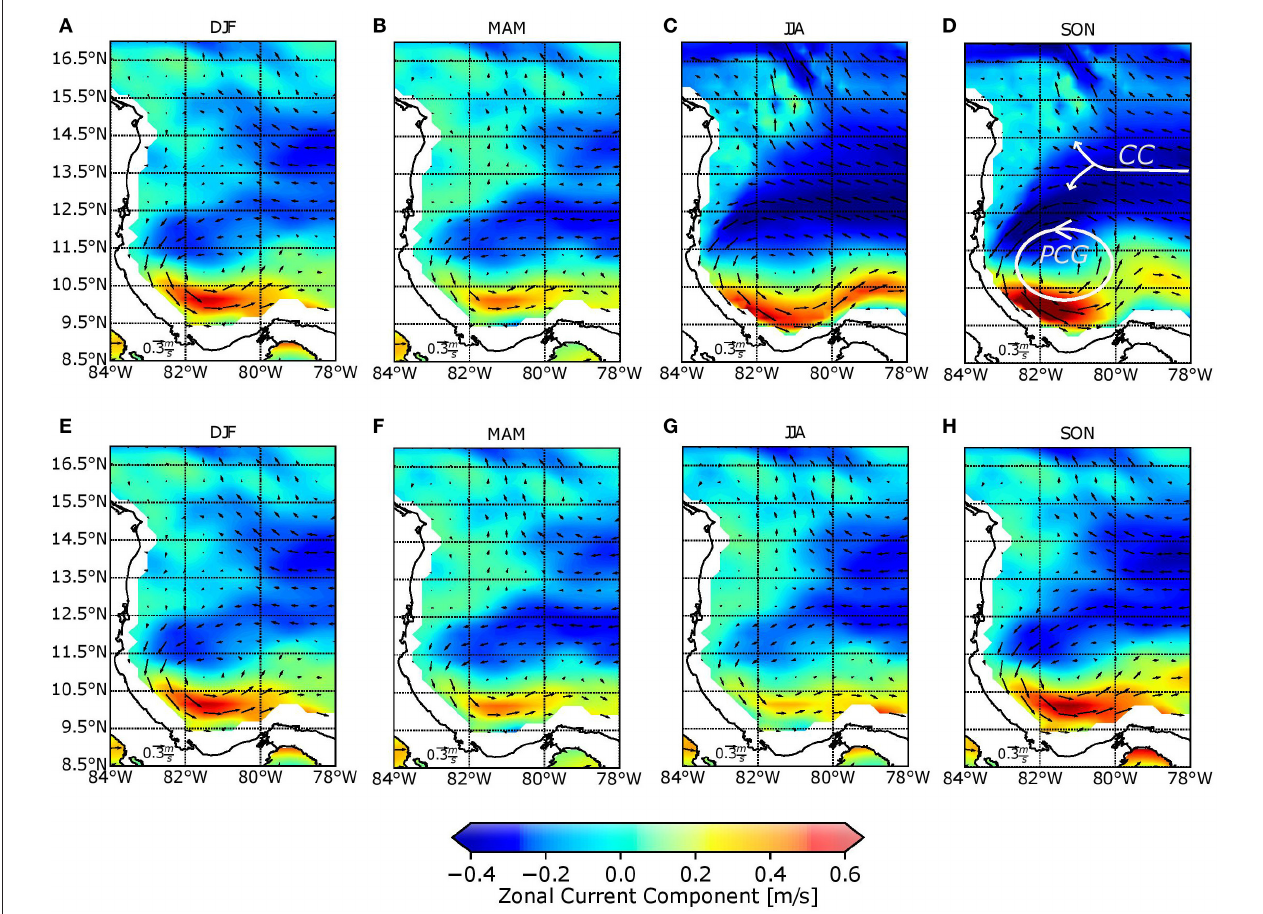
FIGURE 2 | Seasonal behavior of surface currents from model data (upper panels) for: (A) DJF, (B) MAM, (C) JJA, (D) SON and AVISO satellite data (lower panels) for: (E) DJF, (F) MAM, (G) JJA, and (H) SON. DJF, December, January, and February; MAM, March, April, and May; JJA, June, July, and August; and SON, September, October, and